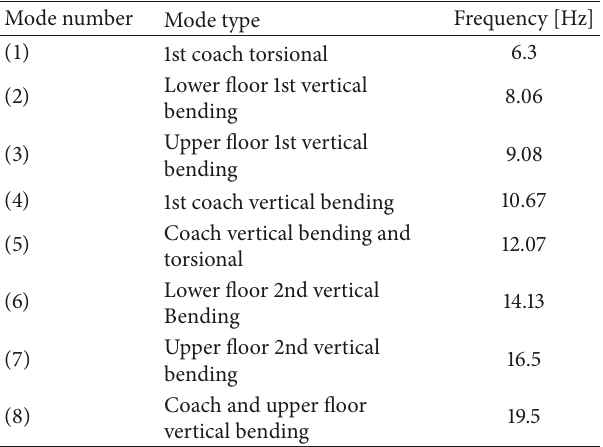
Figure 12: Complete multibody model of the vehicle with flexible coach. Table 7: Natural frequencies of the coach lower than 20 Hz.